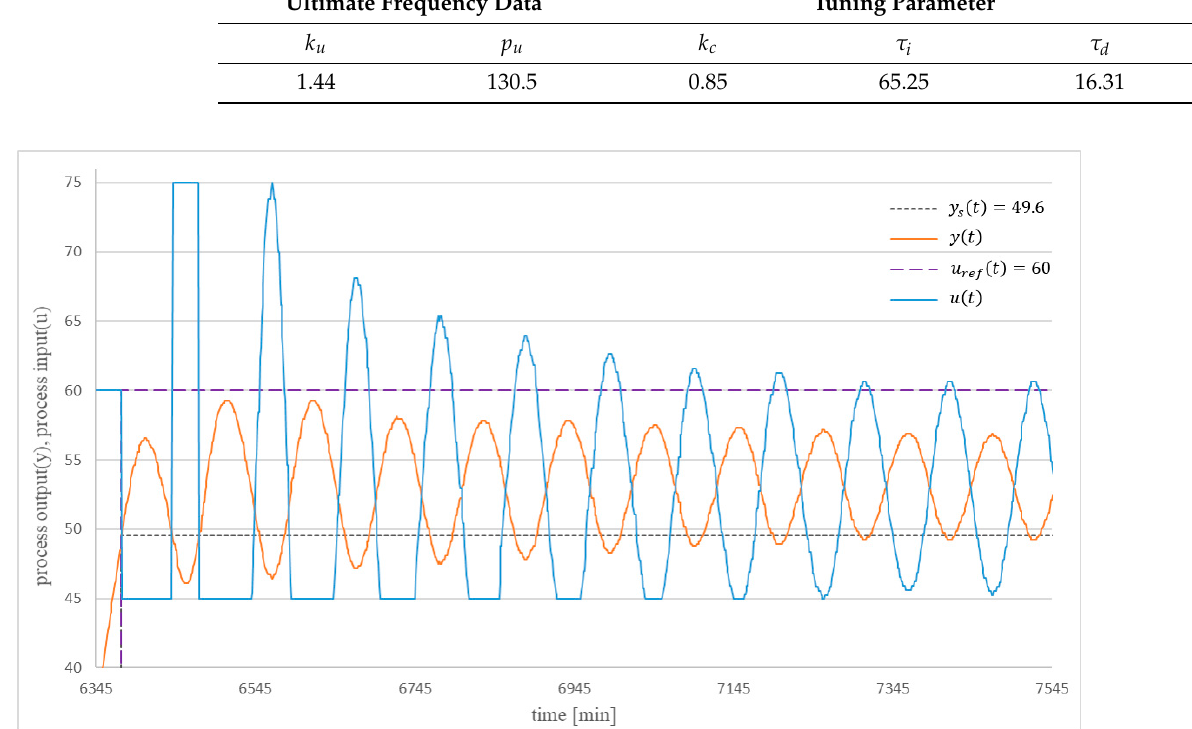
Figure 22. Convergence pattern of the proposed autotuning method.